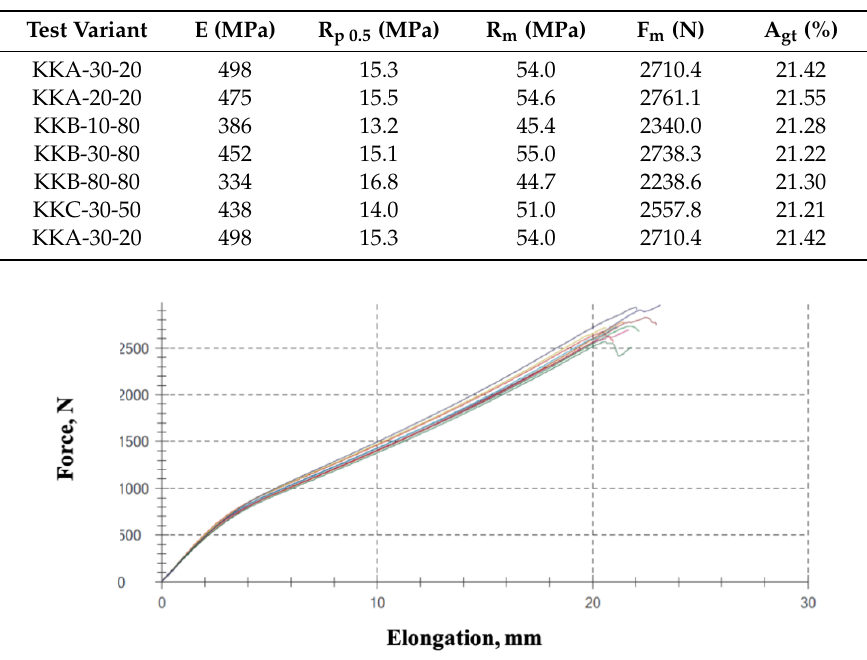
Figure 6. Force versus elongation of conveyor belt samples, KKA-20-20.